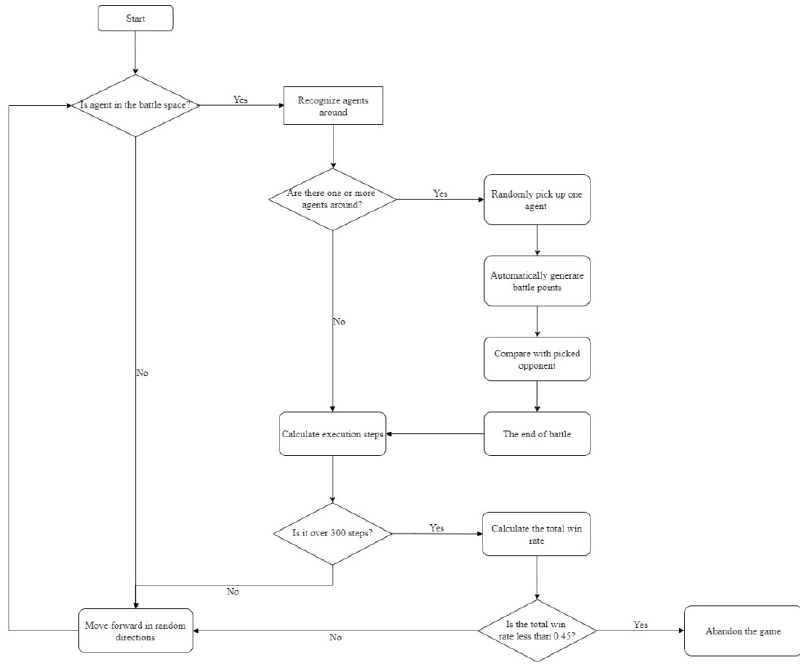
Figure 1. The flow chart of a typical